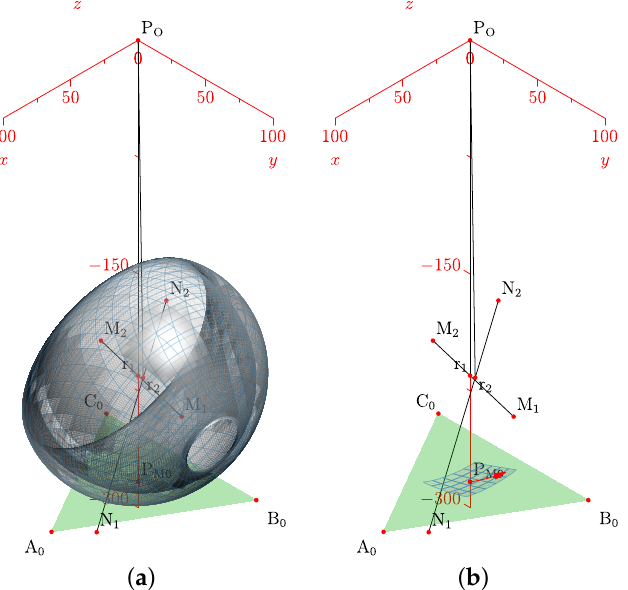
Figure 15. Simulation of the platform central point with variations in the mean statistical values: ( a ) platform’s center point manifold, ( b ) manifold chart and a